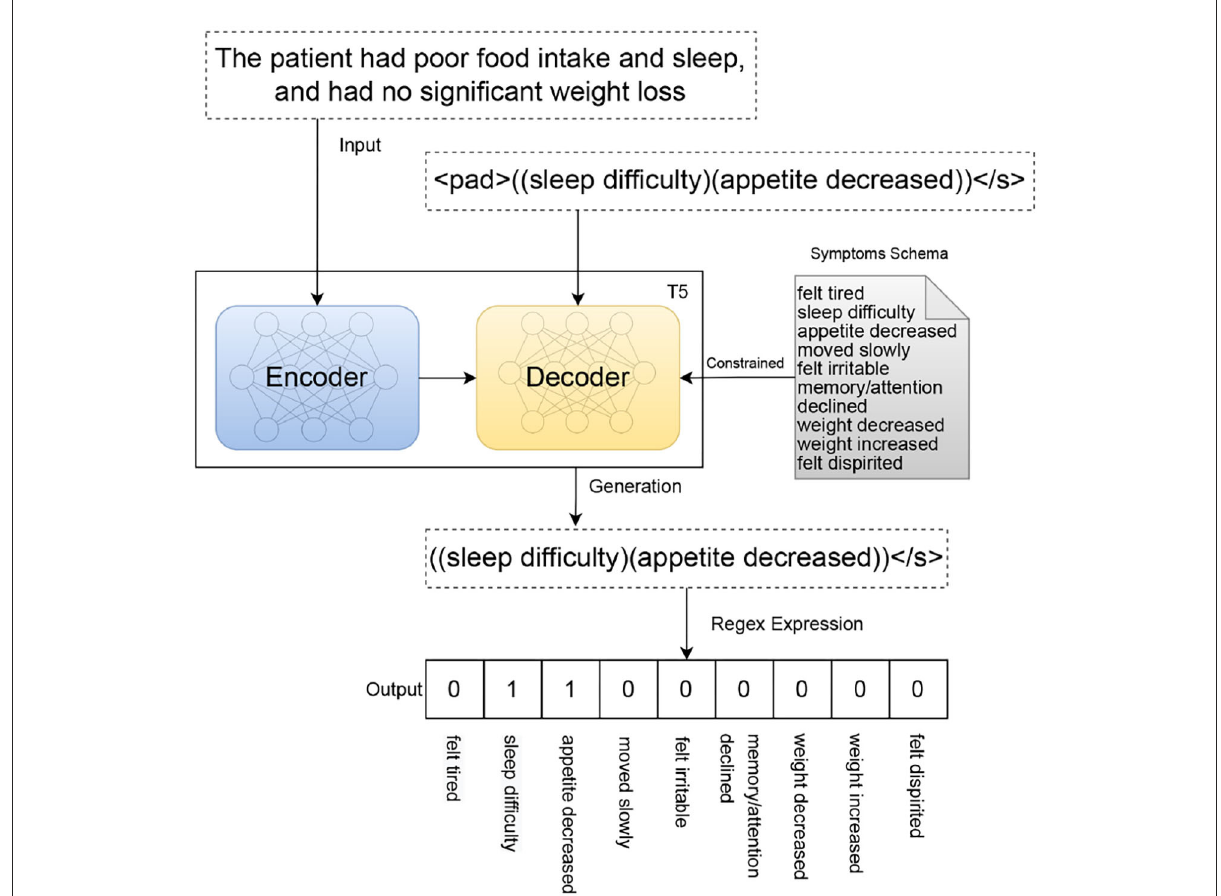
FIGURE1 Architecture of the T5-depression model with formatted input and